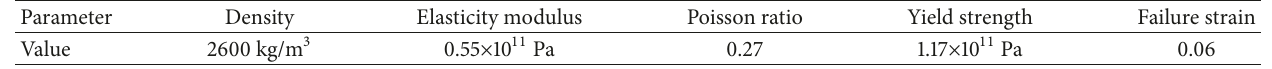
Table 3: Plastic dynamics parameters of granite.